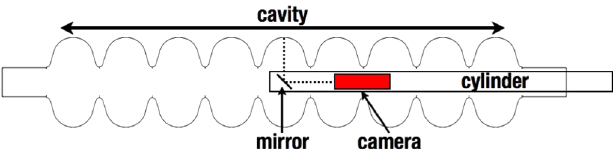
FIG. 1. (Color) Schematic diagram of our cavity inspection system. The cavity swallows the camera cylinder by moving longitudinally. The cylinder does not move. The inner surface reflected in an imaging mirror is observed. The mirror is located in front of the